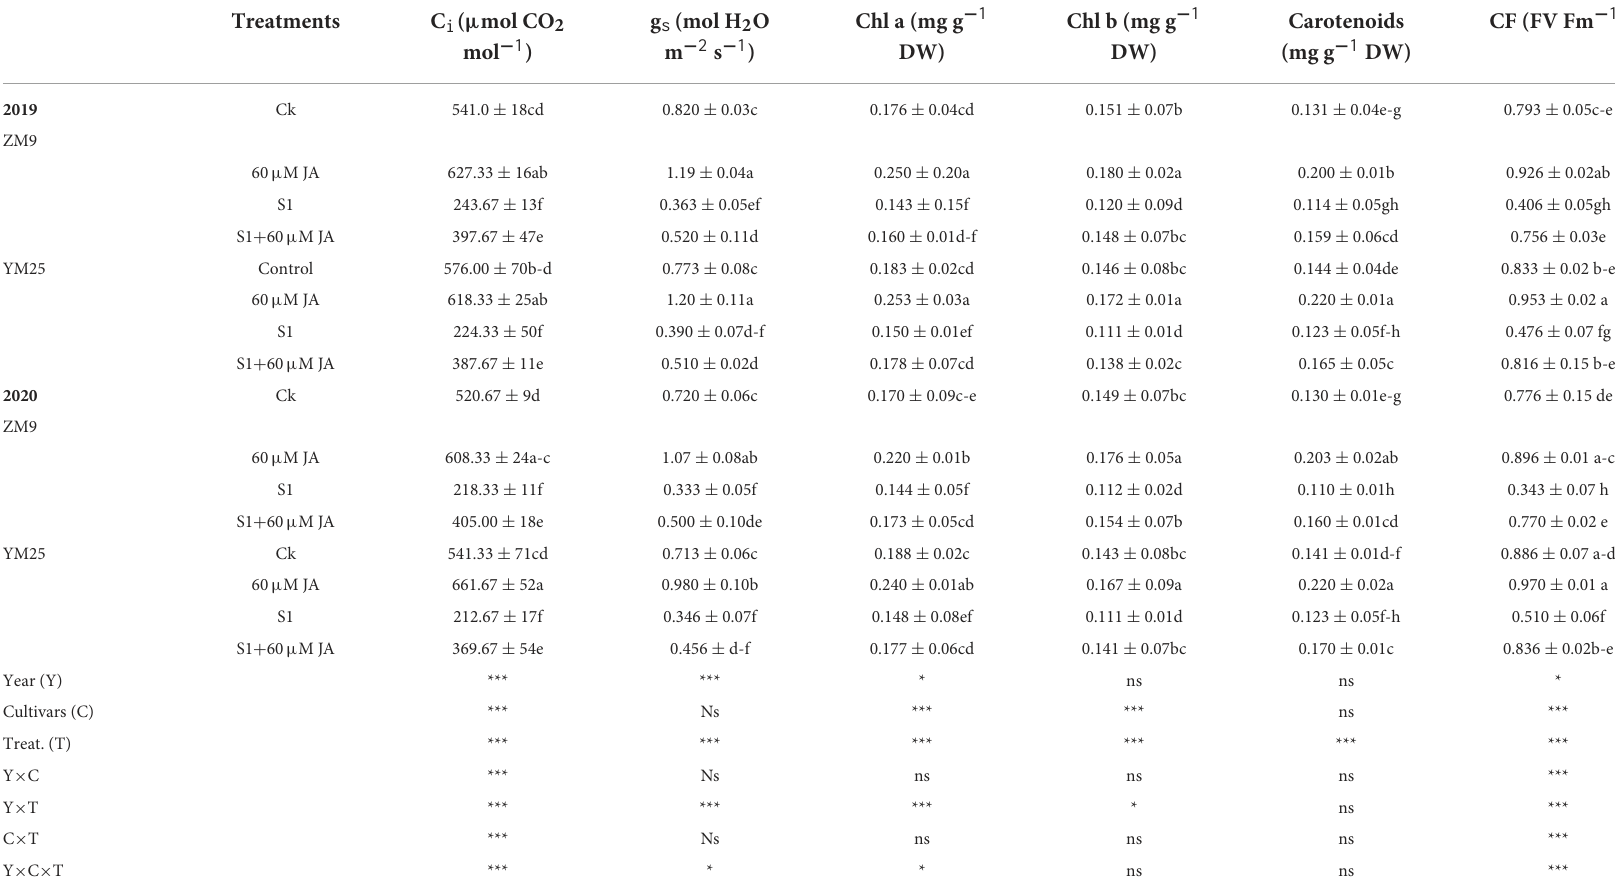
TABLE 2 Effects of JA priming on C i , g s , Chl a and b, carotenoids, and CF (FV/Fm) of two wheat cultivars Mai9 (ZM9, salt-sensitive) and Yang Mai25 (YM25, salt-tolerant) under control and salinity stress conditions during two consecutive growing seasons 2019 and 2020.